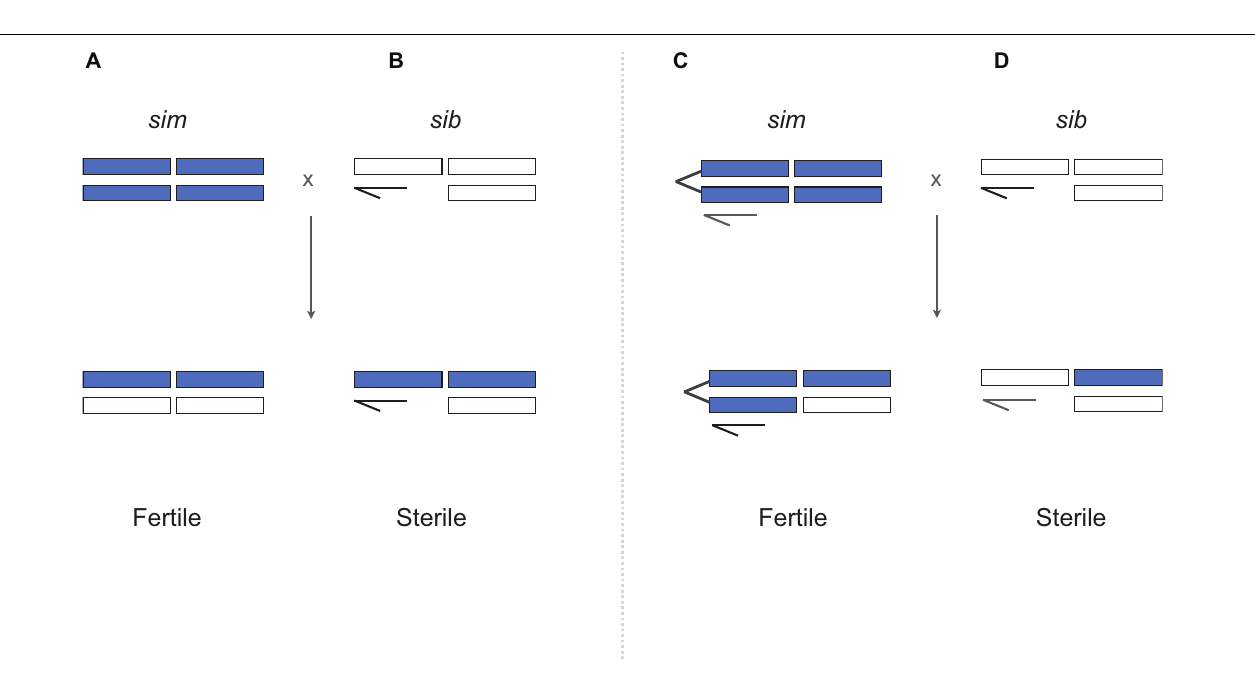
FIGURE 2 | Querying the genetic basis of Haldane’s rule (A,B) using the attached-X test. (C,D) Attached-X chromosomes correspond to two X chromosomes that have been fused together and now segregate as a single chromosome. When D. simulans females carrying an attached-X are crossed to heterospecific males, the female F 1 progeny inherit the sim attached-X and a heterospecific Y chromosome which has no effect in females (sex-determination in Drosophila is determined by the number of X chromosomes). Crosses involving attached-X chromosomes show that hybrid males are sterile (D) and hybrid females are fertile (C) despite having equivalent genotypes (B versus C) . D. simulans ( sim ) material is shown in purple, D. mauritiana or D. sechellia (“ sib ”) material shown in white. Crosses based on Coyne (1985).